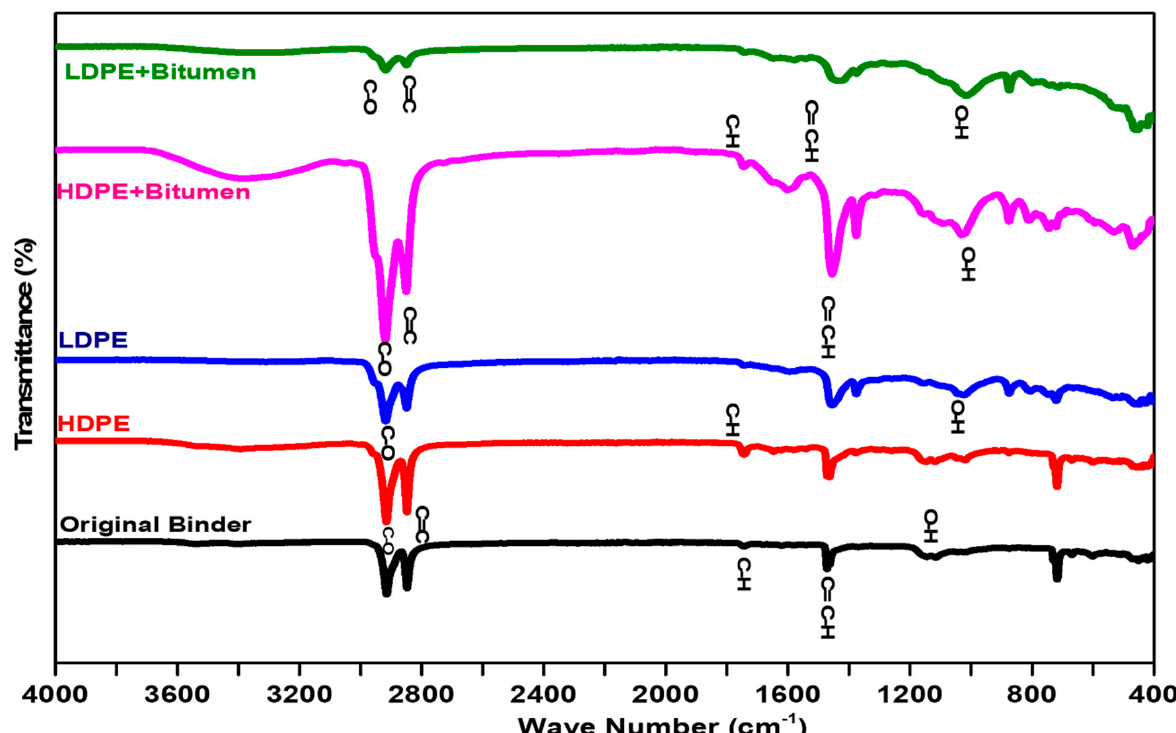
Figure 5. An FTIR analysis of neat, HDPE, and LDPE modified bitumen.